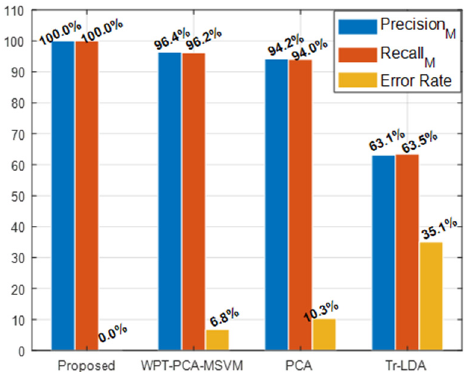
Figure 8. The precision, recall, and errorate obtained from the proposed and reference methods.